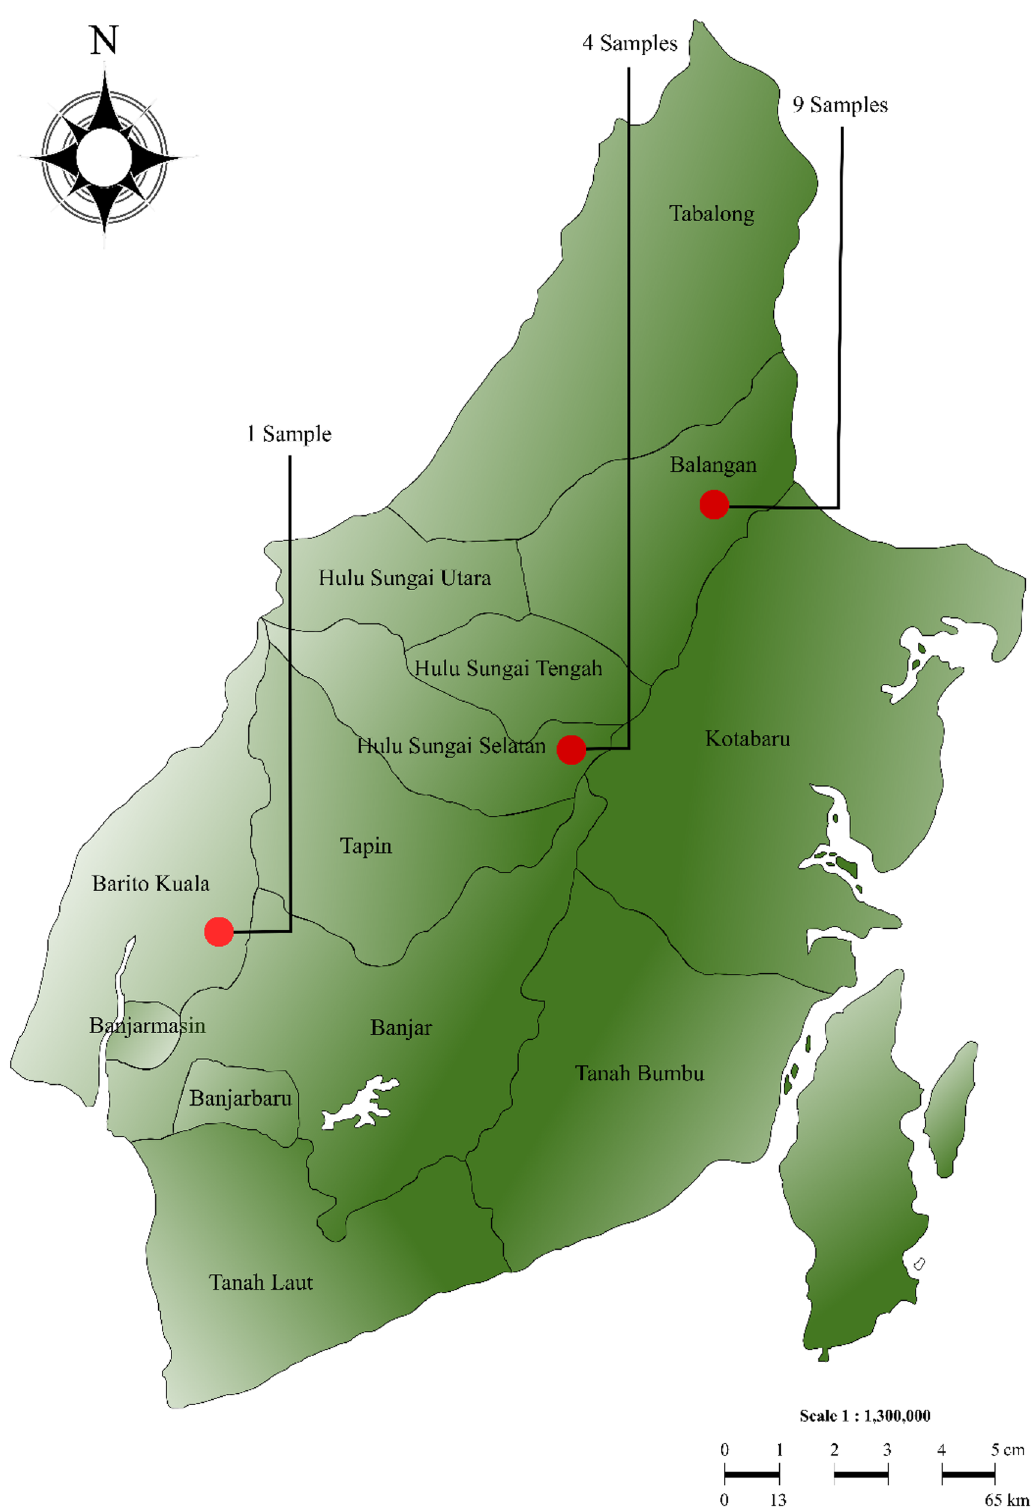
Fig. 1 The map of South Borneo, Indonesia, shows the sampling location and the number of samples collected each. For more information about those samples, see Table